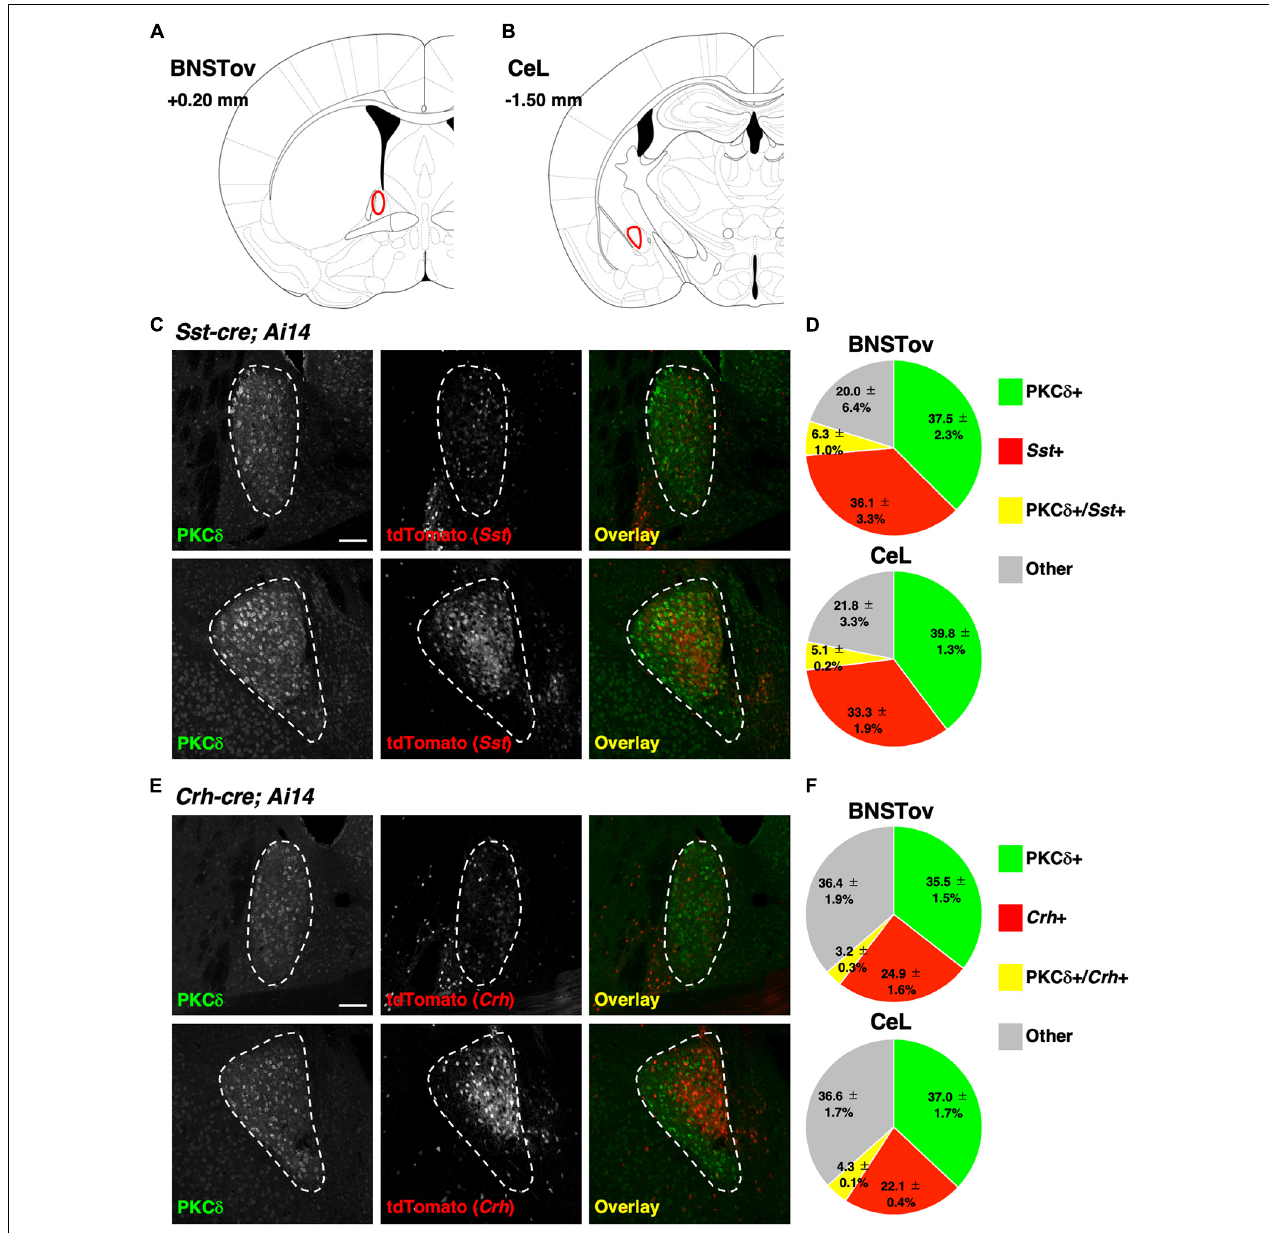
FIGURE 2 | Distribution of genetically defined neuronal populations between the BNSTov and the CeL. (A,B) Schematic brain atlas illustrations at the level of the BNSTov (A) and the CeL (B) . The values indicate anterior–posterior distances from bregma. (C,E) Representative images of the BNSTov (upper) and the CeL (lower) from Sst-cre; Ai14 (C) and Crh-cre; Ai14 (E) mouse brains immunolabeled against PKC δ . White enclosing dashed lines indicate the boundaries of the BNSTov or the CeL. Scale bars, 100 µ m. (D,F) Pie charts showing the proportion of the labeled cells corresponding to ( C,E ; data from 3 mice each). The distribution of genetically defined neuronal populations had no significant difference between the BNSTov and the CeL {Chi-square test, p = 0.961 for (D) , p = 0.964 for (F) }.